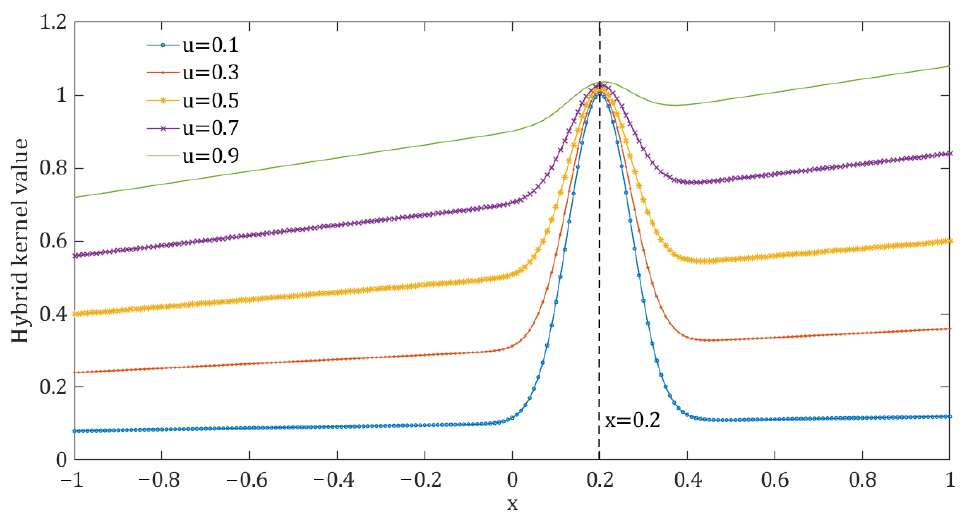
Figure 3. Data distribution of a hybrid kernel function (Gaussian kernel and polynomial kernel; test point x = 0.2).